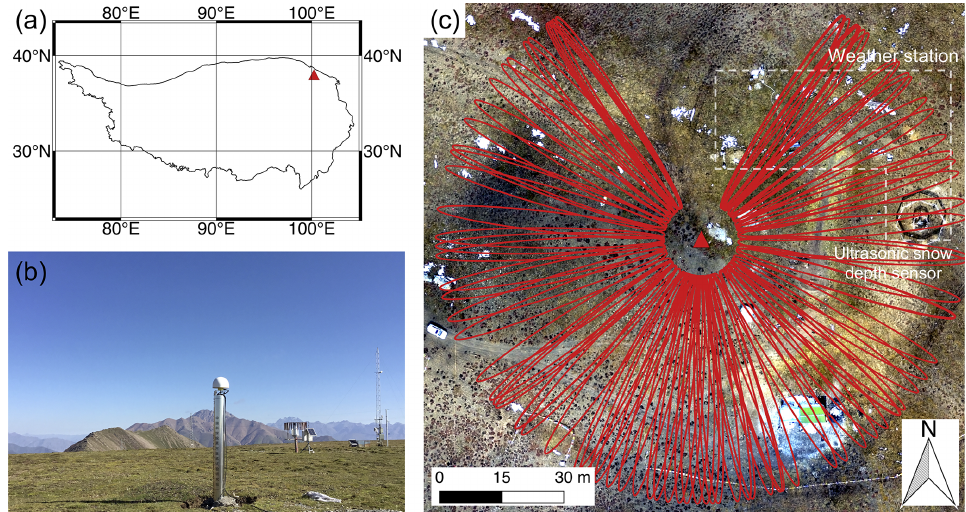
Figure 1. (a) Location of the study site, Binggou, in the northeastern Qinghai–Tibet Plateau. (b) Ground photo of the GPS station QLBG. (c) Orthophoto of the Binggou site showing the surface condition, QLBG (red triangle), and the integrated weather station. Red elliptic curves indicate the footprints of the reflected L1 GPS signals at the satellite elevation angle of 5 ◦ .